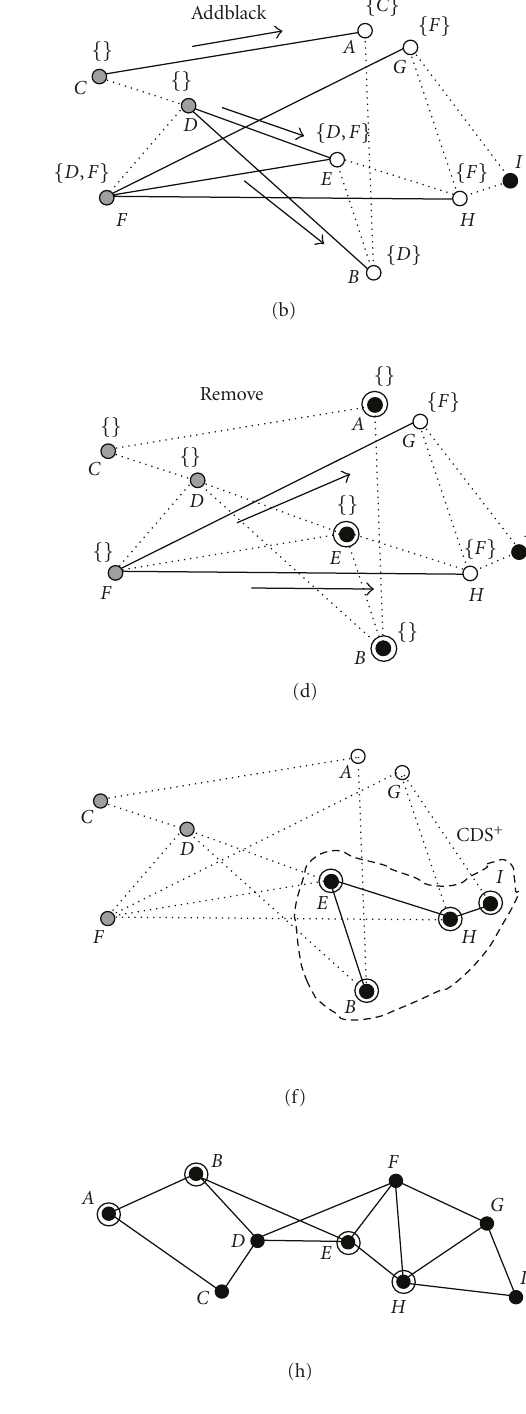
nodes, in other words, to avoid the burden nodes. Therefore, it is not surprising to see that the reorganization overhead in the BACDS model may be lower than that in the MCDS model. The simulation results in Section 5 verify our obser-